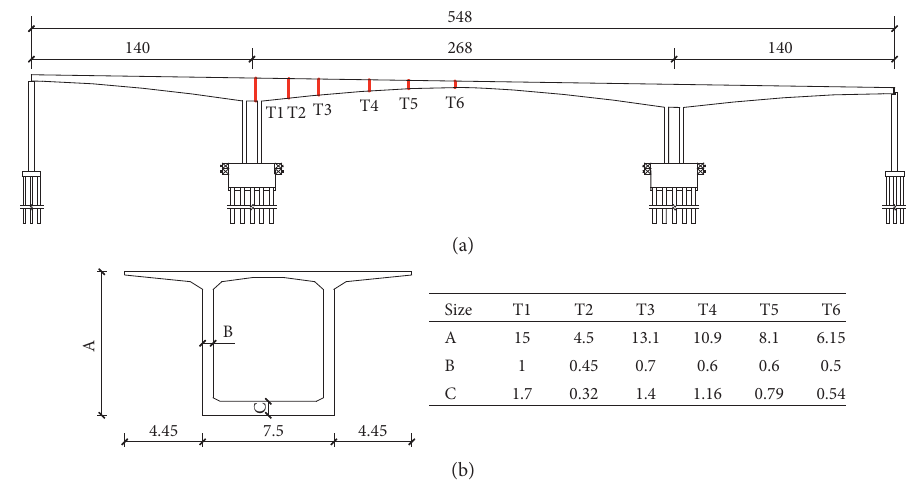
Figure 14: Information for the six cross-sections: (a) locations and (b) characteristic dimensions (unit: m).